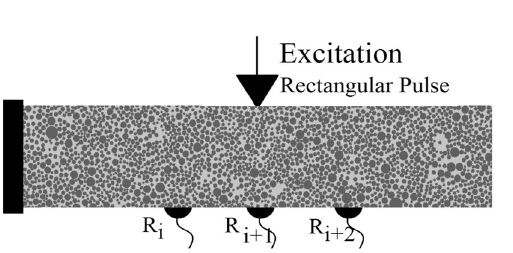
Figure 12. The recorded time histories at the receiver sensors ( R i ) under consideration of different dynamic excitation sources: Ex2, Ex5 and Ex8.